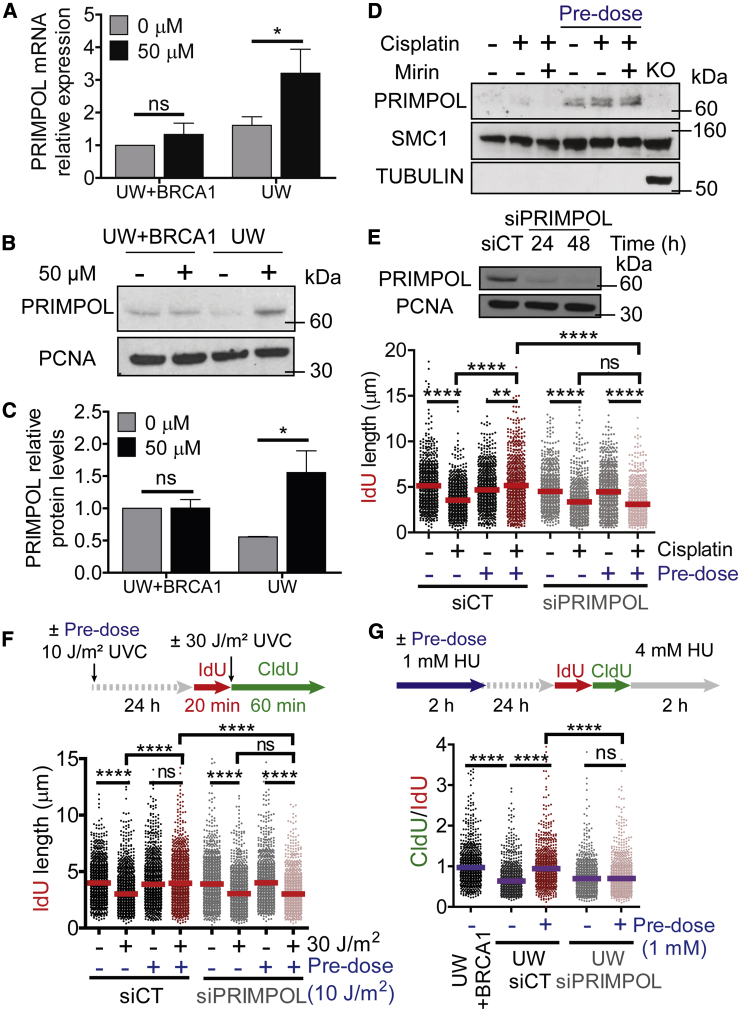
PRIMPOL Rescues Nascent Strand Degradation in BRCA1-Deficient Cells(A–C) PRIMPOL mRNA (A) and protein (B and C) expression 24 h after treatment with 0 or 50 μM cisplatin in UW and UW+BRCA1 cells. (A) Means ± SEM (n = 5) are shown and presented relative to untreated UW+BRCA1 cells. Representative western blot (B) and quantifications (C) from three independent experiments. Statistics: two-way ANOVA followed by Bonferroni test. ns, non-significant, ∗p < 0.05.(D) Chromatin-bound PRIMPOL in UW cells ± 150 μM cisplatin ± 50 μM mirin ± pre-dose. A representative western blot from three independent experiments is shown. Whole-cell extracts of PRIMPOL KO cells confirm the PRIMPOL antibody specificity.(E) Expression of PRIMPOL after siRNA (siPRIMPOL) knockdown in UW cells 24 and 48 h after transfection (top). Dot plot and median of IdU tract lengths in siPRIMPOL or siRNA control (siCT) UW cells ± 150 μM cisplatin ± pre-dose (bottom) (n = 3). ns, non-significant, ∗∗p < 0.01, ∗∗∗∗p < 0.0001.(F) Dot plot and median of IdU tract lengths in siCT or siPRIMPOL UW cells treated with ± 30 J/m2 UVC ± pre-dose (10 J/m2) (n = 3). ns, non-significant, ∗∗∗∗p < 0.0001.(G) Dot plot and median of CldU/IdU ratios in siCT or siPRIMPOL UW cells treated with 4 mM HU for 2 h ± pre-dose (1 mM HU for 2 h) (n = 3). ns, non-significant, ∗∗∗∗p < 0.0001.See also Figure S2.